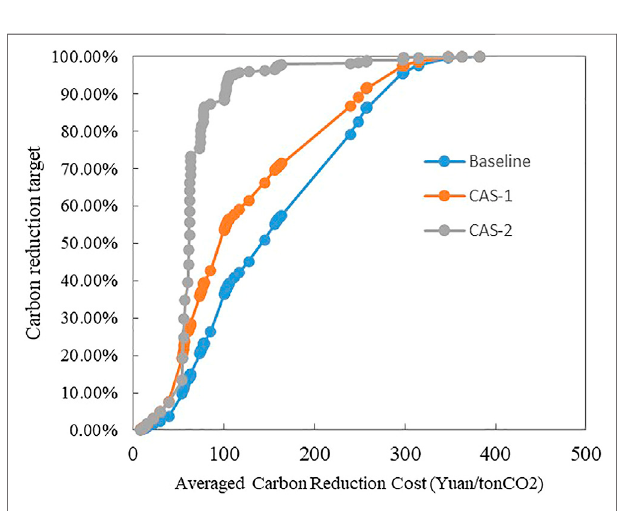
FIGURE 4 | Relationship between total emission reduction rate and averaged carbon reduction cost. Data source: Local Statistical Yearbook and Bureau of Statistics.